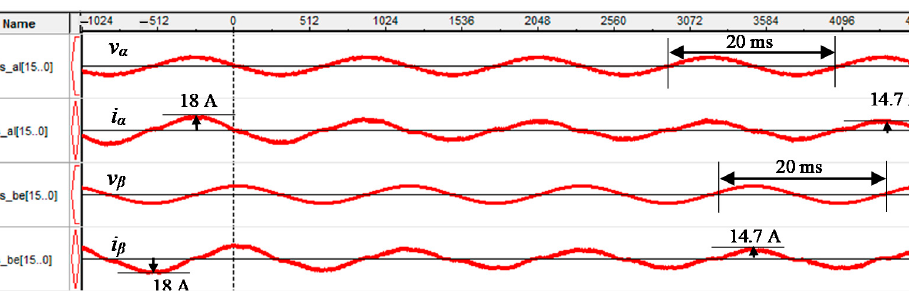
Figure 13. Change in preset power–change in current active component from P N to 0.7 P N .